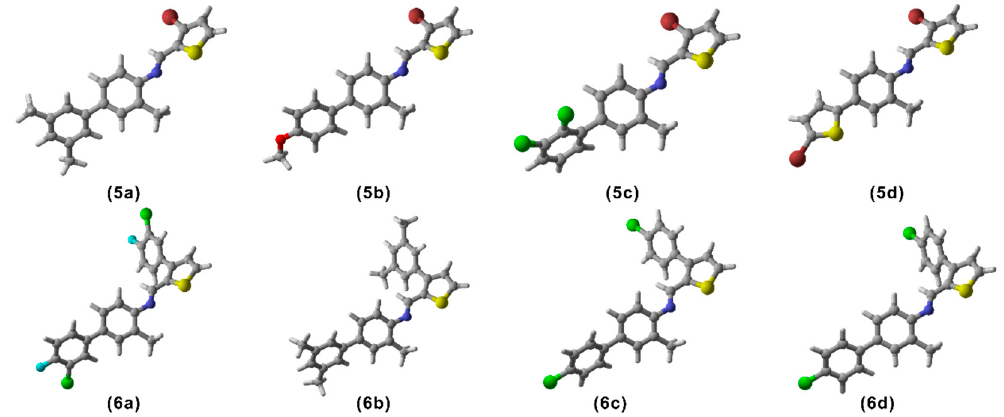
Figure 2. Optimized structures of Synthesized analogues ( 5a – 5d , 6a – 6d ) at PBE0-D3BJ/def2-TZVP/SMD 1,4-Dioxane level of theory. In 3D models, grey colour represents carbon (C), white represents hydrogens (H), green is for chlorine atoms (Cl), red colour represents oxygen (O), brown colour is for bromine (Br), light blue colour is for fluorine (F), and blue colour represents nitrogen (N) atoms.